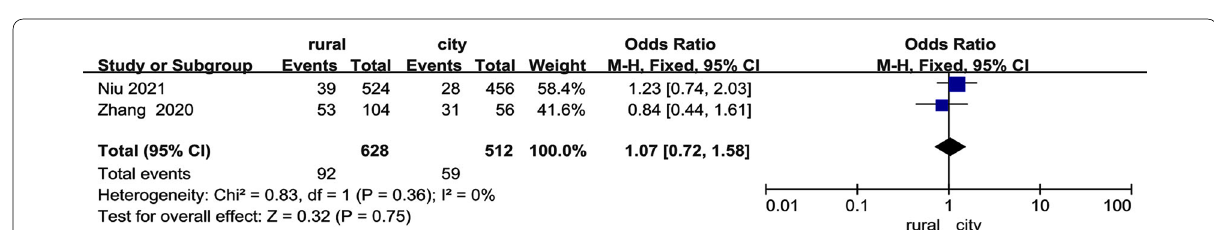
Fig. 8 Forest plot showing the relationship between the location of living place and preoperative DVT in 2 groups. CI confidence interval, df degrees of freedom, M-H